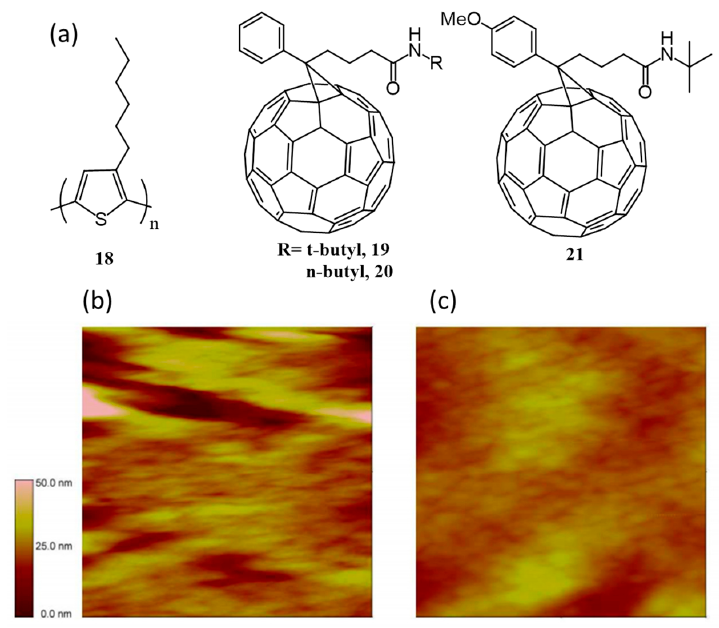
Figure 8. ( a ) Chemical structure of P3HT ( 18 ) and fullerene derivatives ( 19 – 21 ) synthesized by Li et al. [55]. AFM height images of cells fabricated from o -dichlorobenzene solution with the ratio of 1:4 of ( b ) 18 / 20 ( c ) 18 / 21 with 2.5% 1,12-diiodododecane by weight. Adapted with permission from Ref. [55] Copyright 2009 American Chemical Society.